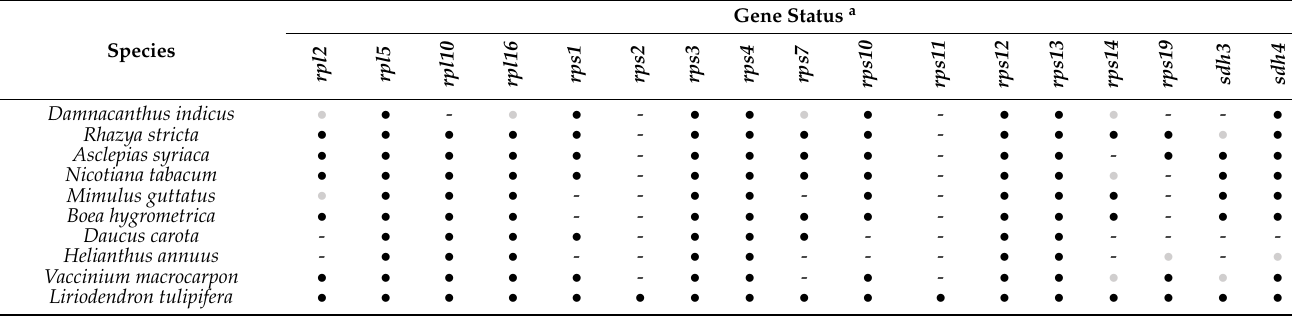
Table 3. The status of 17 variable mitochondrial protein-coding genes of Damnacanthus indicus and representatives of